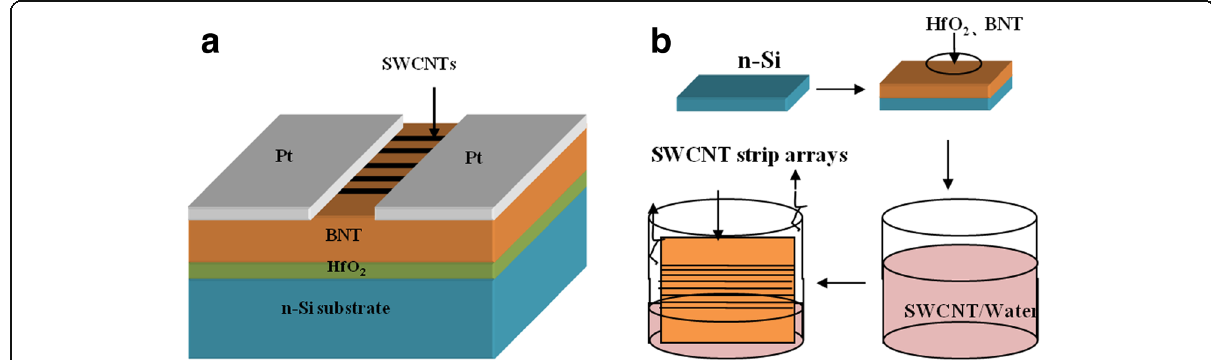
Fig. 1 a The structure diagram of the stripe patterned SWCNT-FeFET. b Flow chart of the stripe patterned SWCNT/BNT/HfO 2 -FeFET